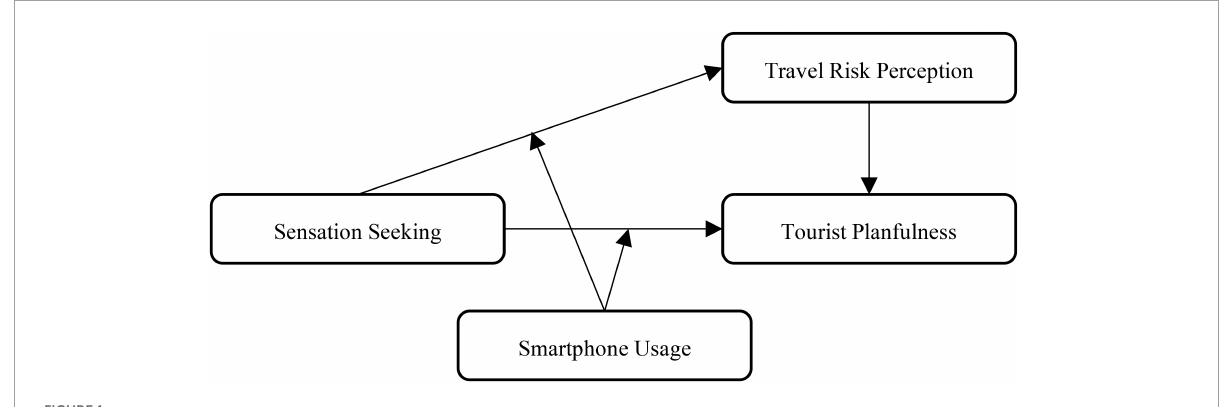
FIGURE1 The proposed model.